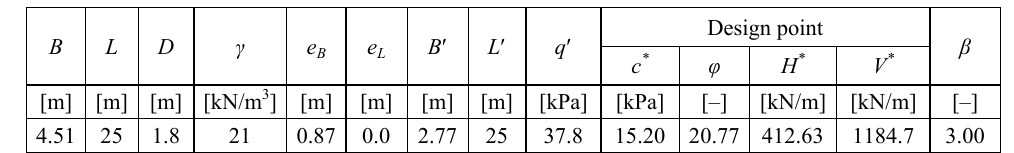
Table 3. Results of probabilistic computations